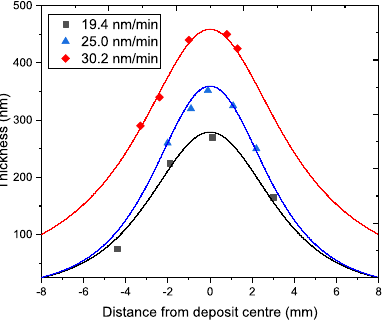
Figure 9. Data and fit of deposits distribution centered at the jet axis as a function of the growth